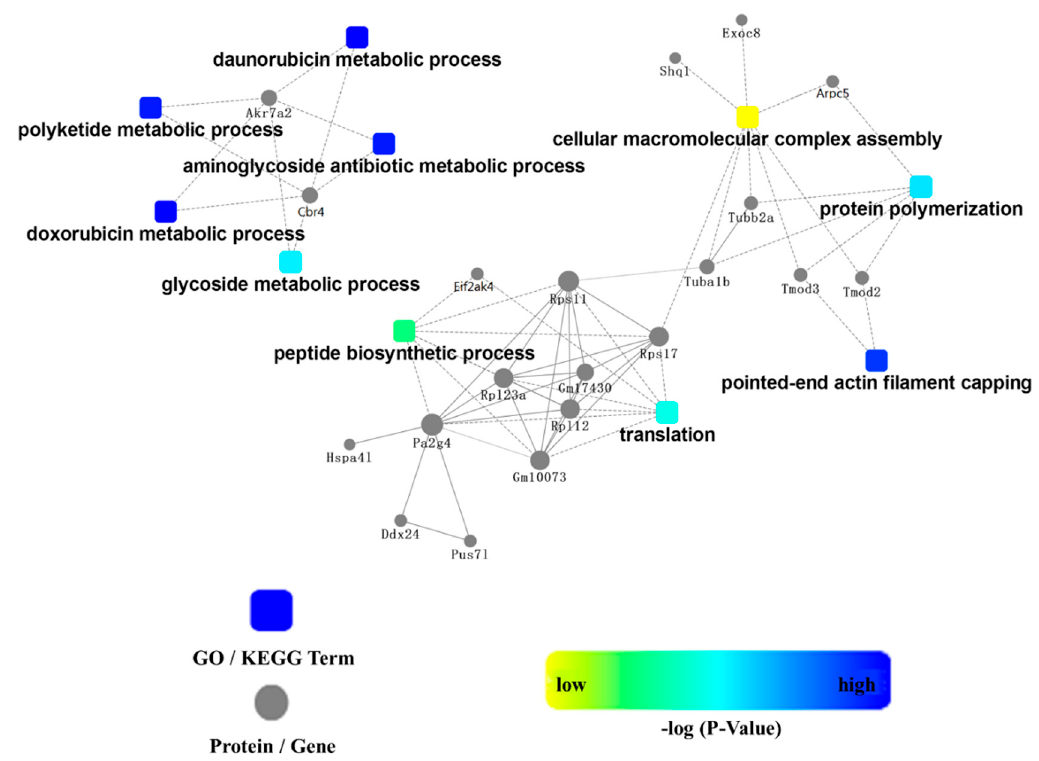
Figure 6. PPI network. Proteins are represented by dots and signaling pathways are indicated by rounded rectangles.